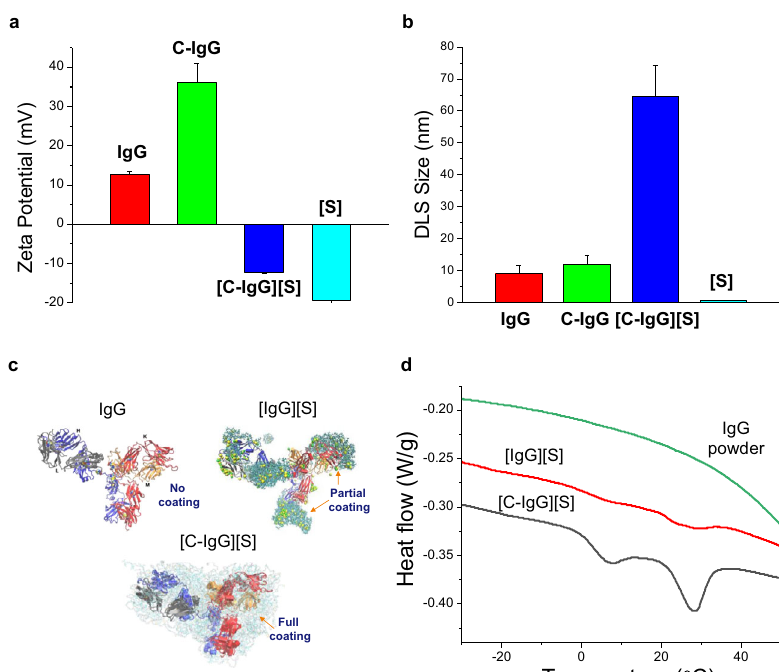
Fig. 1 Characterization of antibody liquid. a Zeta potential measurements of rabbit IgG antibodies after cationization (C-IgG) and complexation with anions [C-IgG][S]. Error bars represent the standard deviation from three separate measurements. b Dynamic Light Scattering (DLS) plot of rabbit IgG antibodies after cationization (C-IgG) and complexation with anions [C-IgG][S]. Error bars represent the standard deviation from three separate measurements. c Molecular structures of IgG antibodies, IgG with anions of [S] added (labeled [IgG][S]), and [C-IgG][S] antibody liquid obtained after 200 ns of molecular dynamics simulations. d Differential scanning calorimetry (DSC) plot of [C-IgG][S], IgG powder only, and [IgG][S] at a1:4 wt